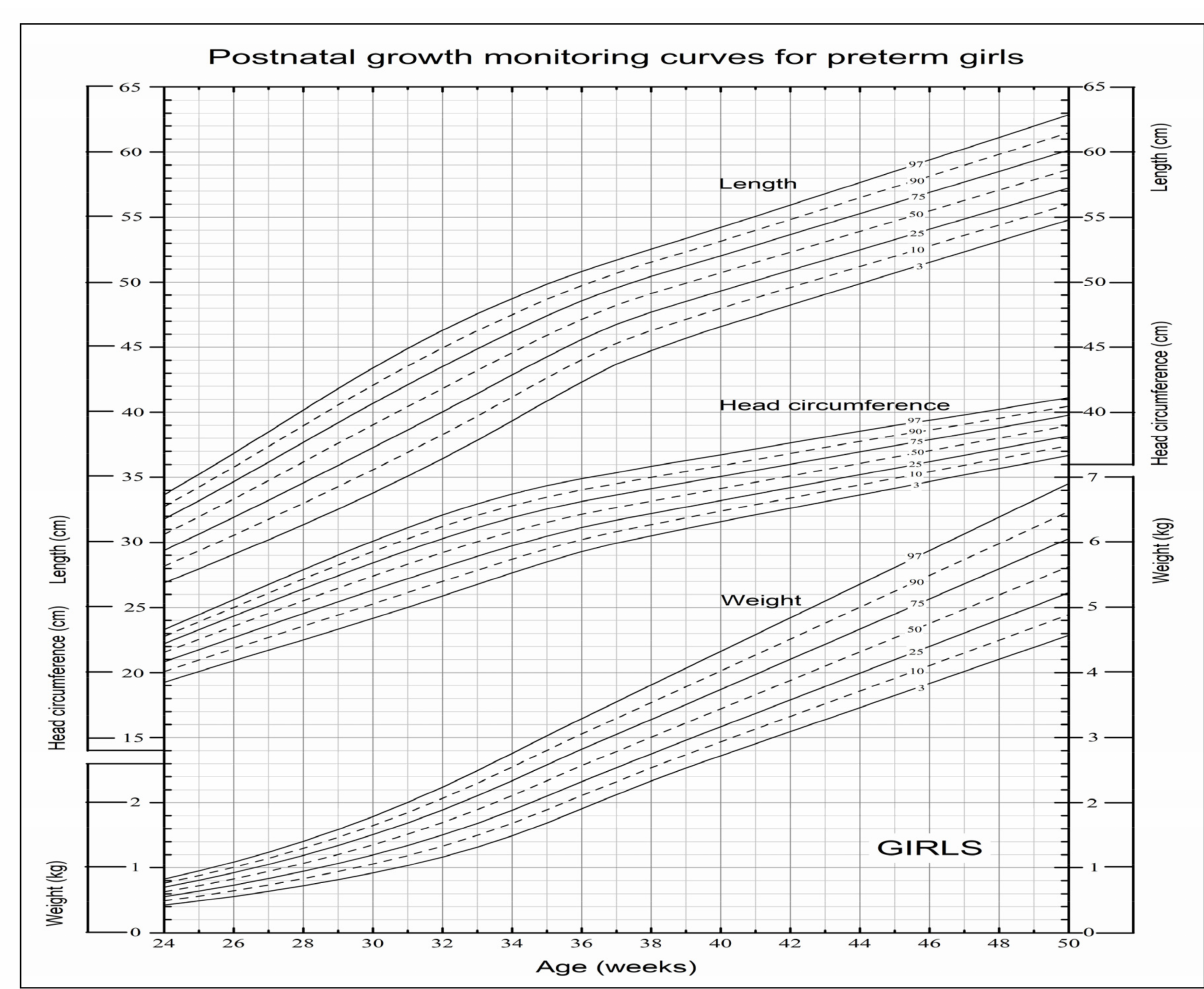
Figure 3. Postnatal growth monitoring charts for preterm girls in